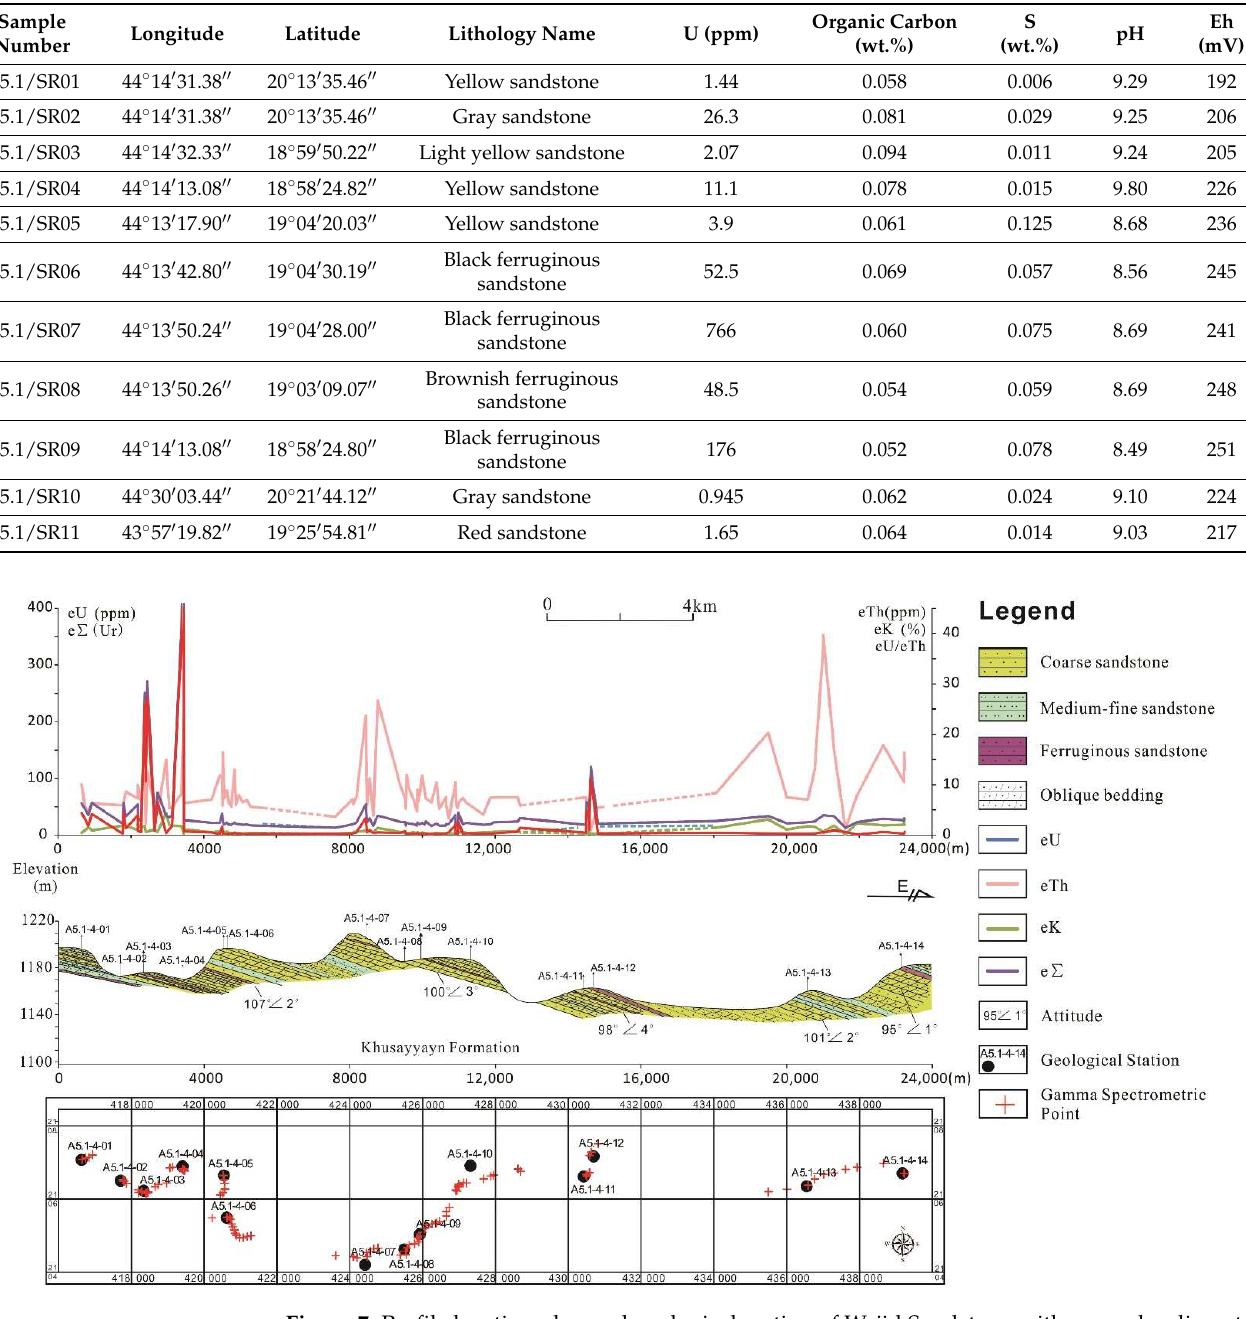
Figure 7. Profile location plan and geological section of Wajid Sandstone with ground radiometric surveys profiles. Table 3. U-Ra equilibrium coefficient table in study area.